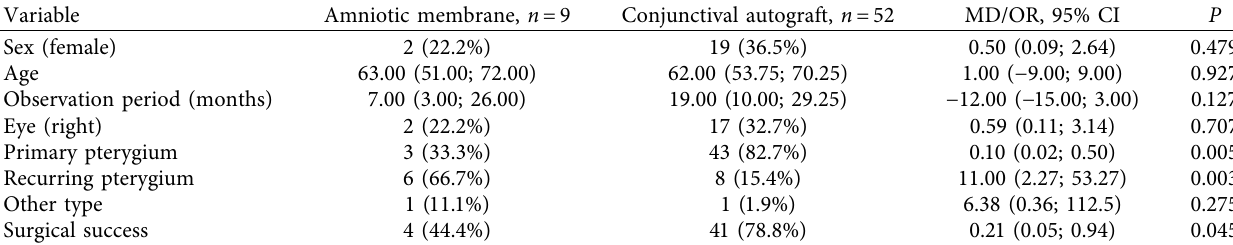
Table 1: Characteristics and comparison of groups (amniotic membrane vs. conjunctival